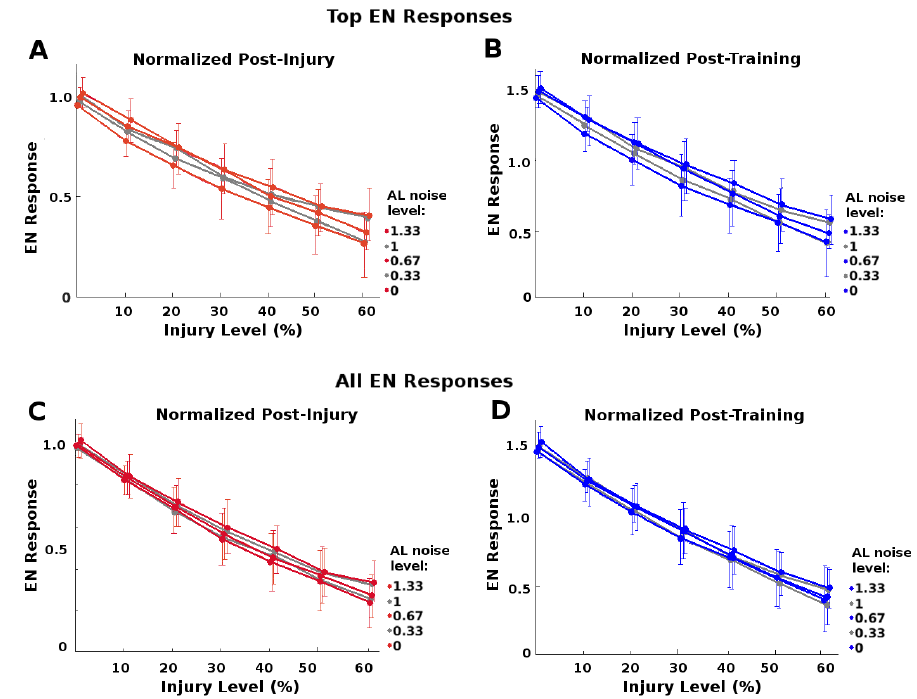
Figure 7. Protective effects of AL noise on strongest vs. average EN responses: Given RN injury, increased AL noise had a greater protective effect on the top 15% tranche of EN odor responses than on more average odor responses, both post-injury and post-training. Each curve corresponds to a noise level. A wider spread of curves indicates greater injury mitigation from higher noise. ( A , B ): Top 15% of EN responses, normalized to their pre-injury responses, post-injury (red, grey) and post- training (blue, grey). (These are the same subplots as in Figure 6A,B.) ( C , D ): All responses, normalized by their pre-injury responses, post-injury (red, grey) and post-training (blue, grey). Average EN responses had less injury mitigation benefit from high noise than top-scoring EN responses, seen in the narrower